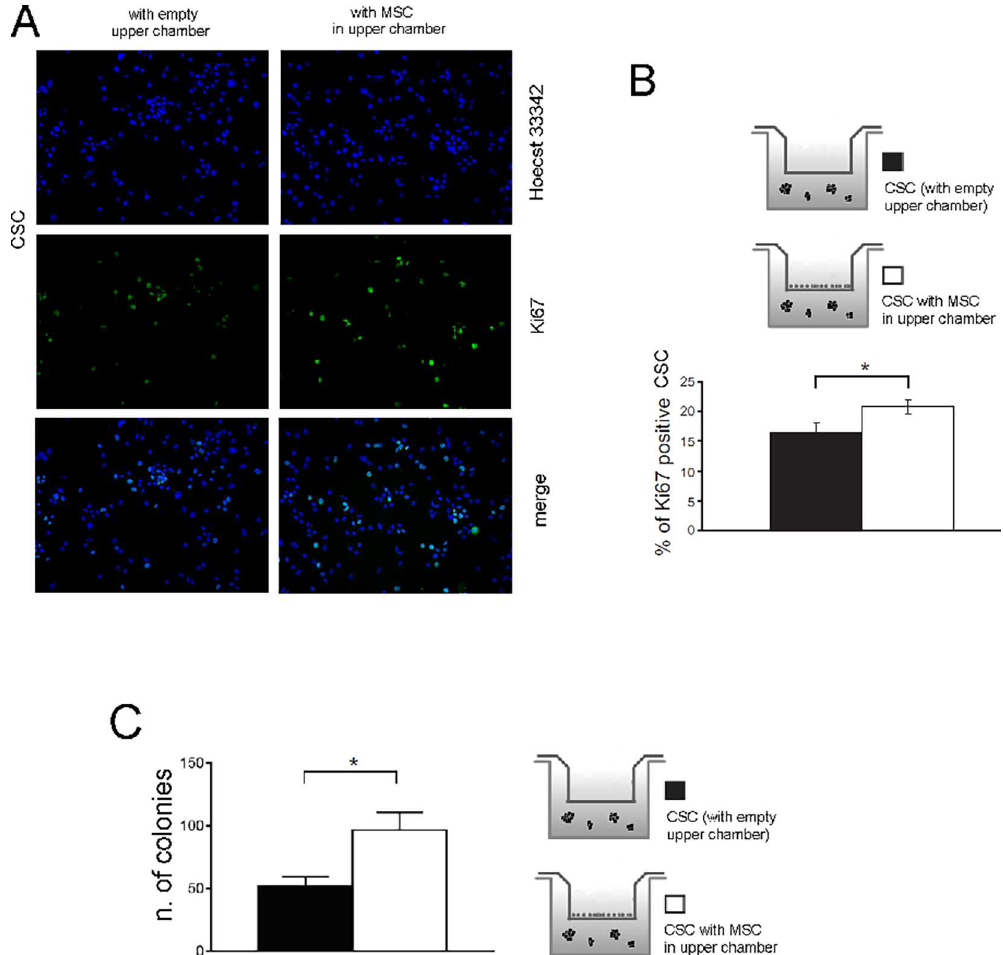
Fig 4. MSC increasethe proliferation of HOS-CSC. Homotypiccultures of CSC or co-cultures of CSC+MSC for 3 days were trypsinized,fixed and immunostained with anti-Ki67antibody (green). Hoecst 33342(blue) was used to counterstain nuclei. (A) Representative image; (B) The percentage of Ki67 positive nuclei was quantified and expressedas ratio to the total number of cells ( * p < 0.05). Ki67 expressionwas increasedin the presence of MSC as comparedto CSC cultured alone.Images were acquired using the same exposuresetting. Original magnification 20X. Figure shows representativeimages. (C) The number of coloniesformed by HOS-CSC co-culturedwith MSC were evaluatedon soft-agar and quantified.MSC secreatome enhancedHOC-CSC